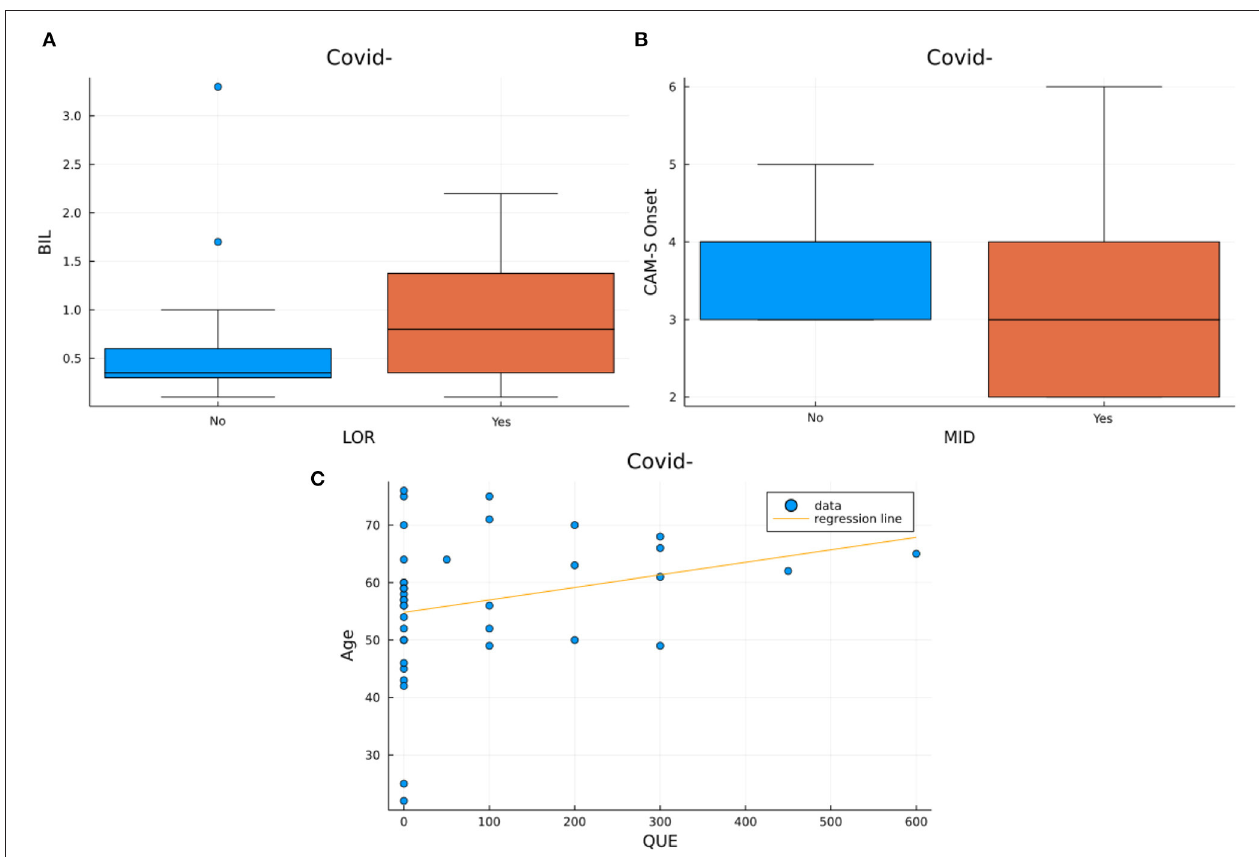
FIGURE 4 | Visualization of the significant results from the correlations in the COV–/DEL + group. Box plots represent the bilirubin levels distributions in subjects assuming LOR vs. subjects not assuming LOR ( Figure 3A ) and the distribution of different CAM-S scores at the onset of delirium in subjects assuming MID and in subjects not assuming MID ( Figure 3B ). The scatter plot with regression line ( Figure 2D ) represent age vs. maximum dose of quetiapine